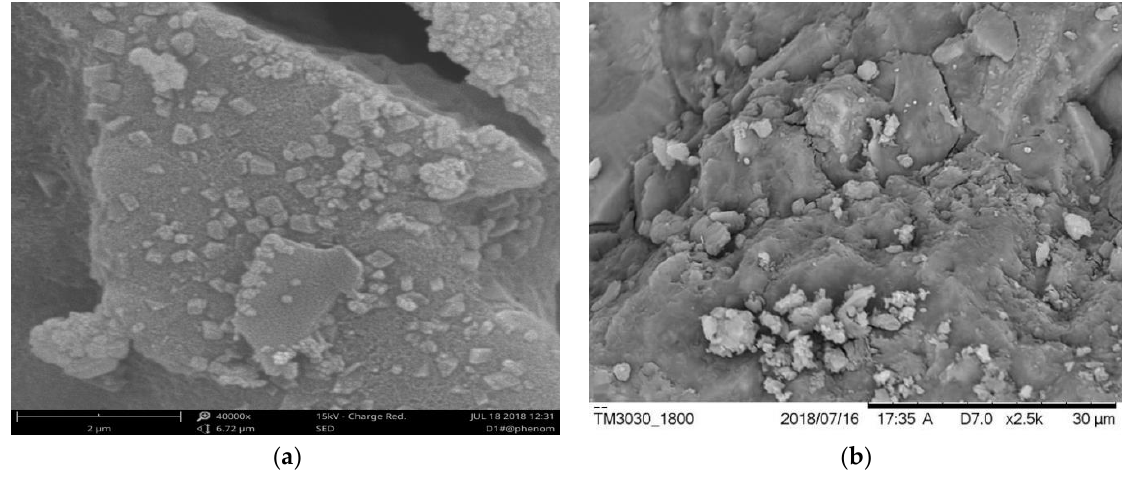
Figure 11. SEM photos of specimens: ( a ) modulus is 1.1; ( b ) modulus is 1.3 [28].